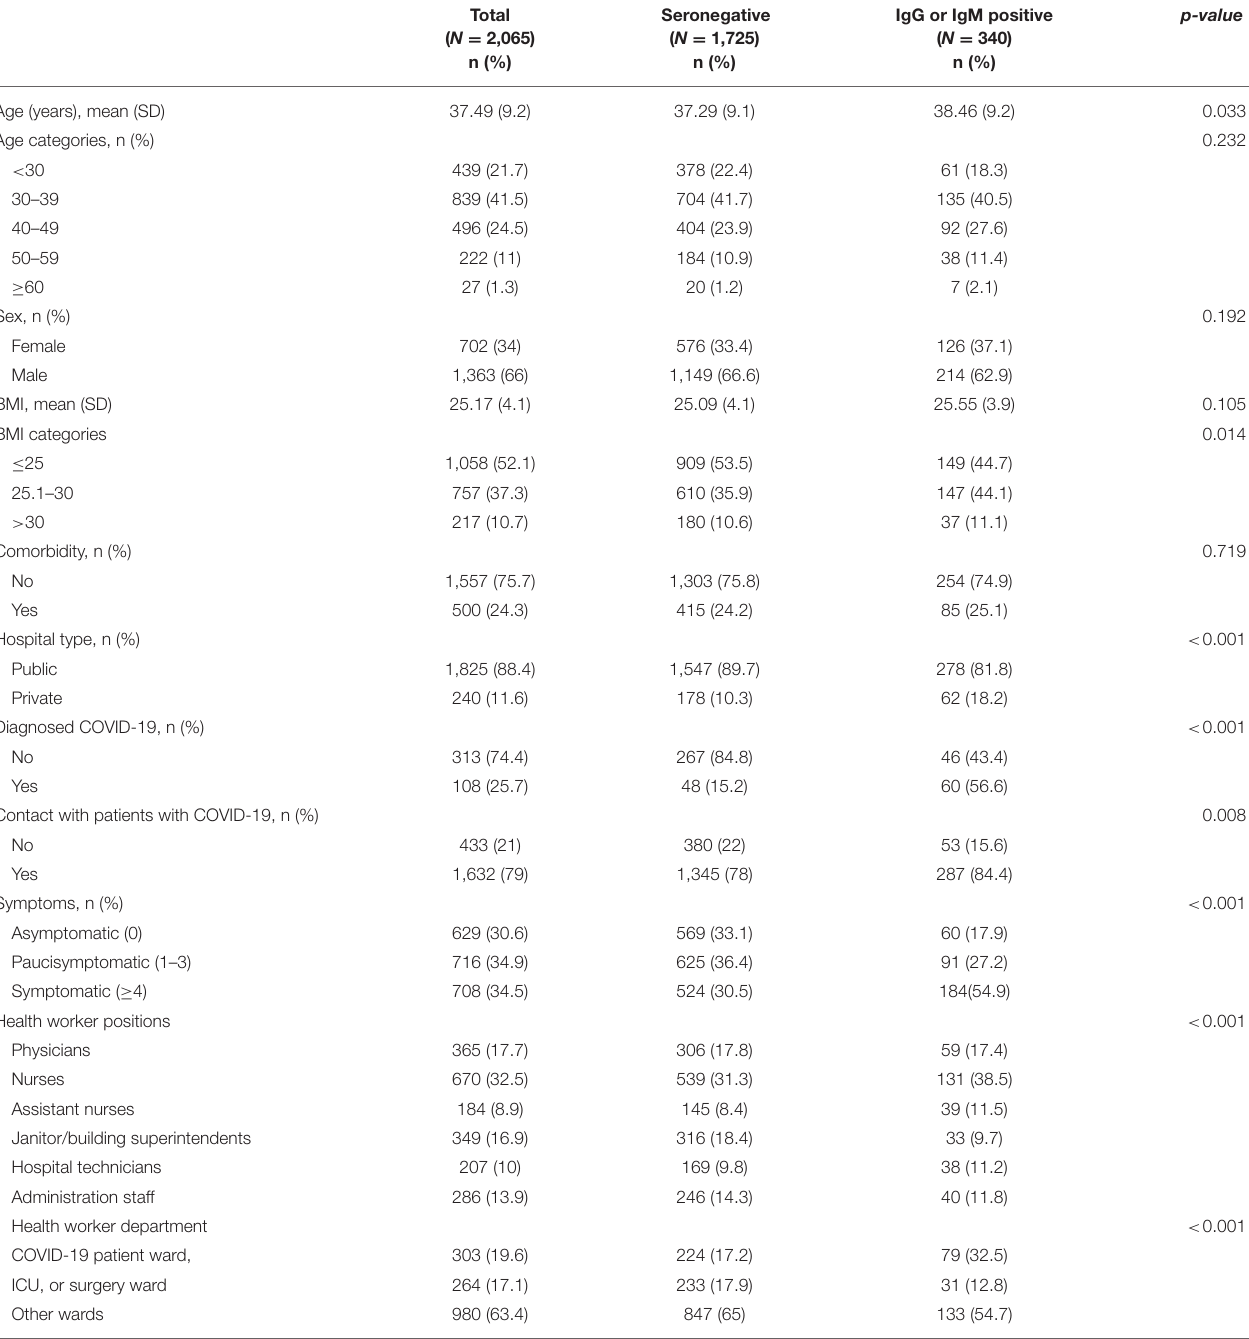
TABLE 1 | Baseline